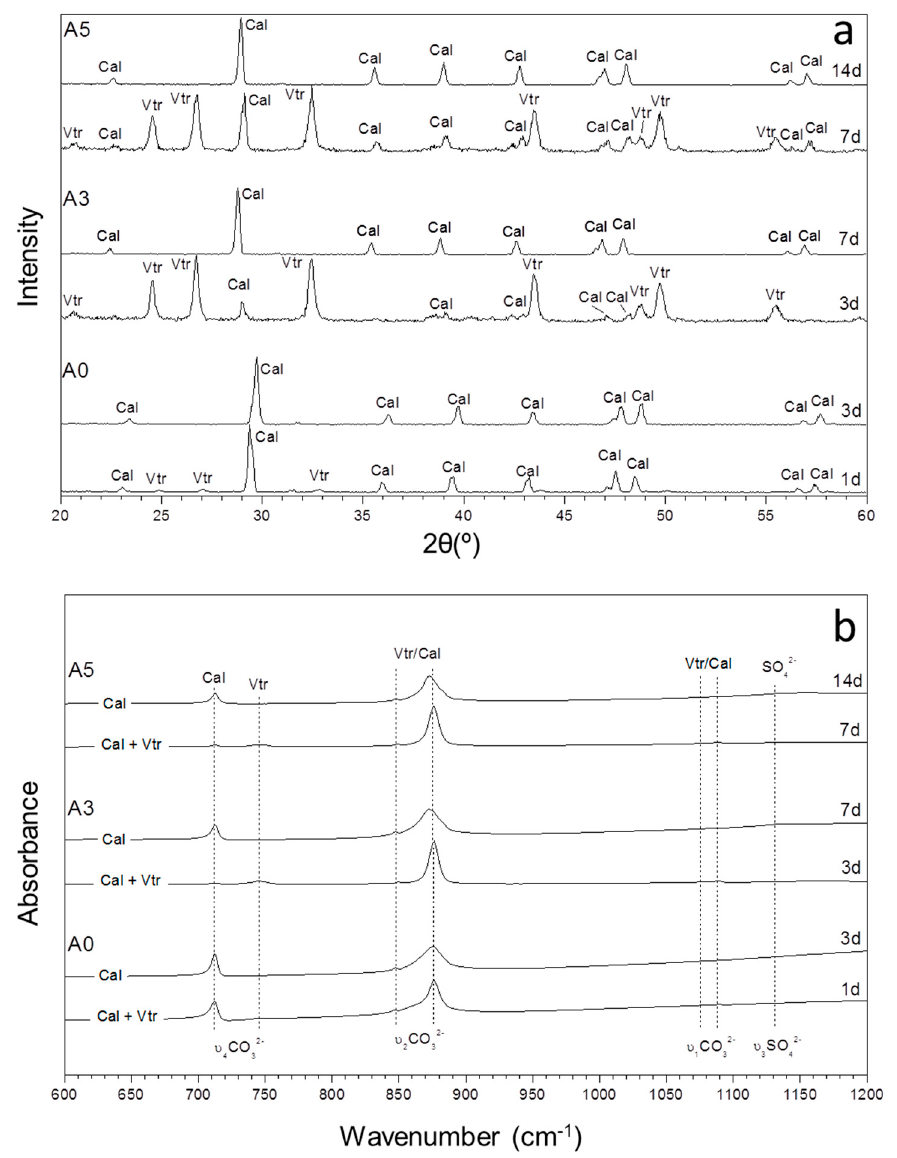
Figure 2. The XRD patterns ( a ) and infrared spectra ( b ) of precipitates sampled from aqueous solutions with low (SO 42 − )/(CO 32 − ) ratios (A0–A5) as a function of time. A different mineralogical evolution trend is observed in experiments A7 to A20, where the initial (SO 42 − )/(CO 32 − ) ratio in the aqueous solution varies between 19.51 and 54.87 (Figure 3). In this case, the formation of aragonite is also observed during ageing. This CaCO 3 polymorph appears as a constituent of the precipitate formed after ageing times that are shorter, as the initial (SO 42 − )/(CO 32 − ) ratio in the aqueous solution is higher. Thus, aragonite is detected in the precipitate formed in A7 and A15 after 7 days of ageing, while this phase is found much earlier in the precipitate formed in A20 after only 1 day of ageing. This evolution trend is particularly evident in the FTIR spectra, which show weak bands at approx. 699 cm − 1 and 712 cm − 1 and at approx. 855 cm − 1 , consistent with the positions of the υ υ 4 antisymmetric bending and 2 out-of-plane vibrations of carbonate ion in aragonite, respectively. These bands are absent in the precipitates formed after short times of ageing (3 days and shorter